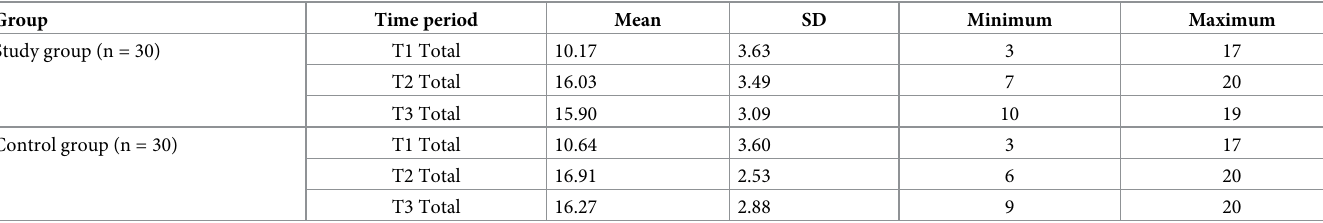
Table 4. Mean knowledge scores of the pregnant women in the study and control groups at T1, T2, and T3.